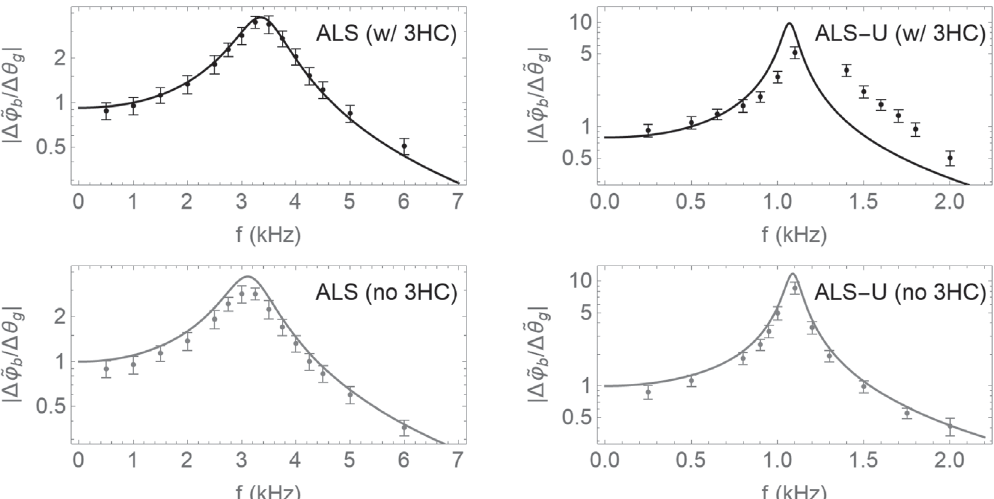
FIG. 1. Amplitude of the beam-centroid response to a sinusoidal perturbation of the rf generator phase with frequency f ¼ ω = 2 π , in the presence (top) and absence (bottom) of higher-harmonic passive cavities as calculated by macroparticle simulations (dots) and theory (curves). The curves with/without 3HCs are from Eq. (27) [with the functions G defined in (41)] and (33), respectively. The peak p;q frequency response is higher and the peak amplitude is lower in the ALS (left) compared to the ALS-U (right). Note the difference in scale in both the horizontal and vertical